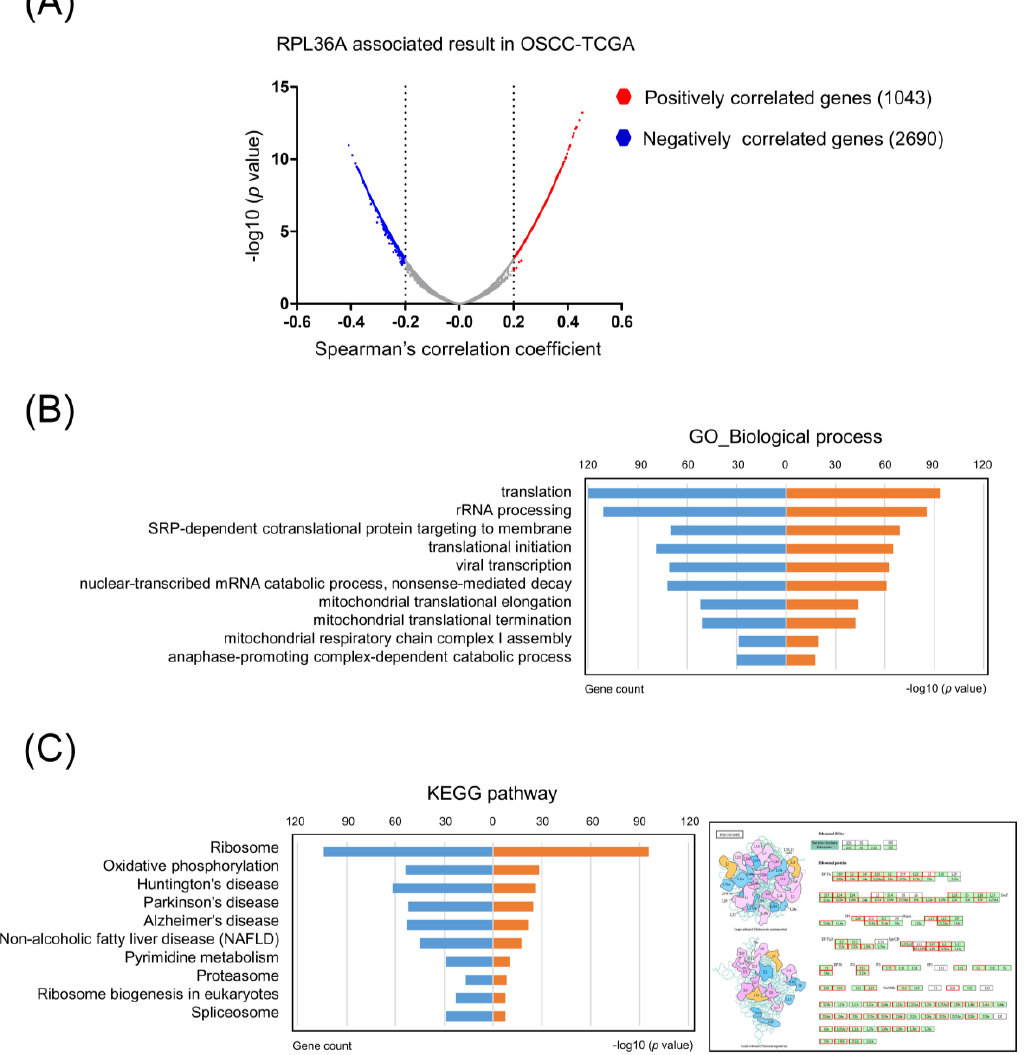
Figure 3. Core molecular pathways and gene ontology annotations of RPL36A-associated genes in OSCC-TCGA: ( A ) Volcano plot of the correlation between the expression of RPL36A and all the other genes in OSCC-TCGA. The x-axis indicates Spearman’s correlation coefficient. The y-axis indicates the adjusted p -values plotted in − log10. Red dots indicate the genes positively correlated with RPL36A (Spearman’s correlation coefficient > 0.2). Blue dots indicate the genes inversely correlated with RPL36A (Spearman’s correlation coefficient < −0.2). Enrichment analysis of the 1043 genes positively associated with RPL36A in the OSCC-TCGA dataset; ( B ) significantly enriched GO biological process annotations; ( C ) significantly enriched KEGG pathways (left). KEGG pathway annotations of the ribosome pathway (right). The nodes indicated in red represent genes with expression levels positively correlated with RPL36A.